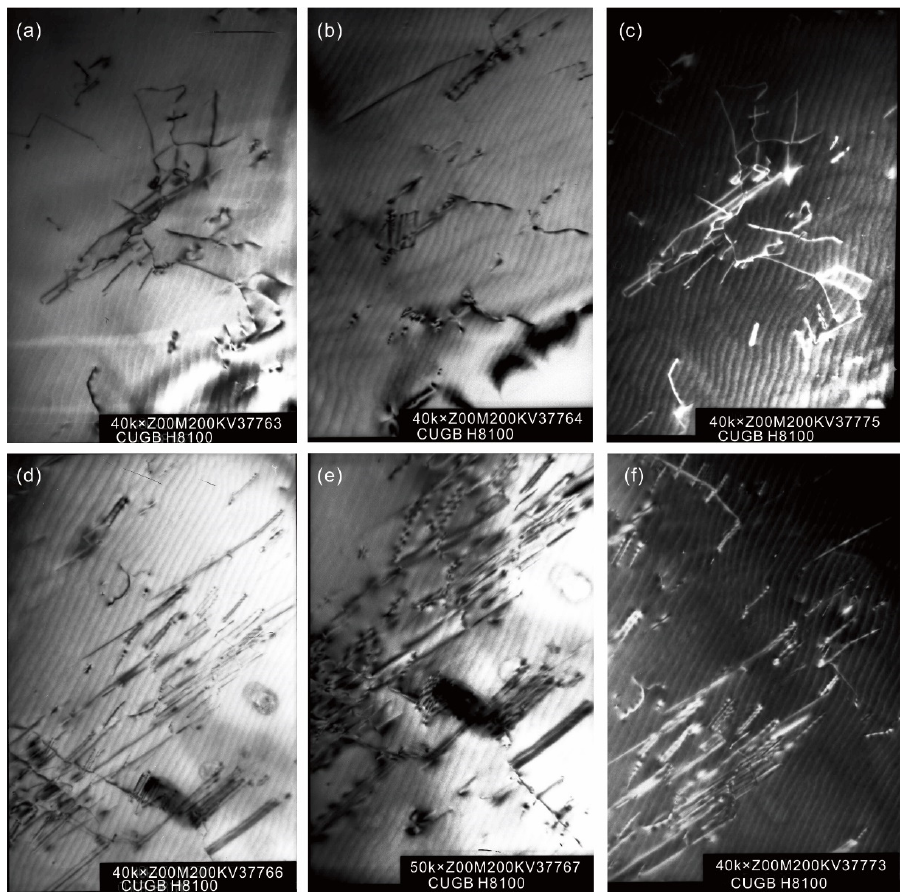
Figure 8. The pictures of dislocation and stacking faults in transmission electron microscopy (5 cm in width) for sample MY-38. Dislocation pictures in light field ( a , b ) and in center of dark field ( c ); Stacking faults in light field ( d , e ) and in center of dark field ( f